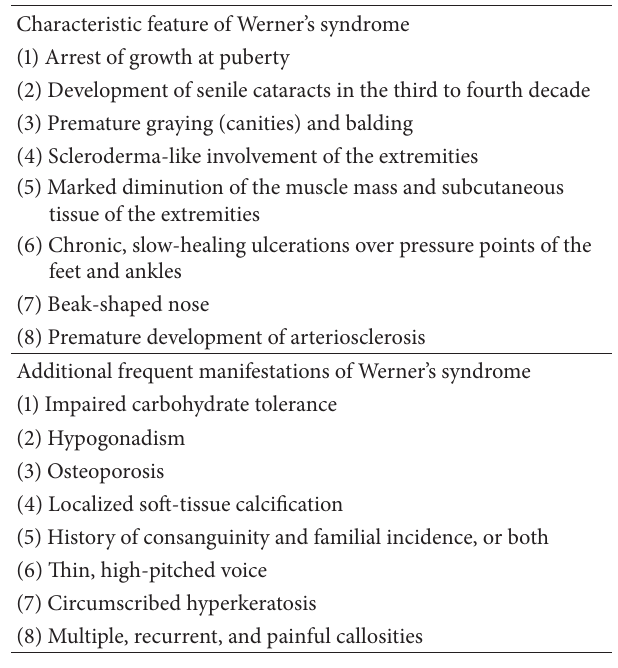
Figure 5: Five days after operation, ultra-thin split thickness co- vered this region. Table 1: Findings in Werner’s syndrome.